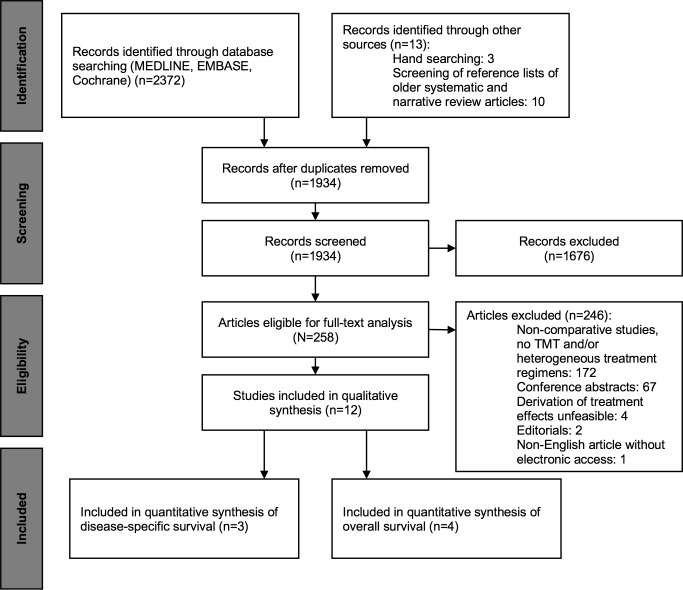
PRISMA (Preferred Reporting Items for Systematic Reviews and Meta-Analysis) flow diagram illustrating the study selection process.